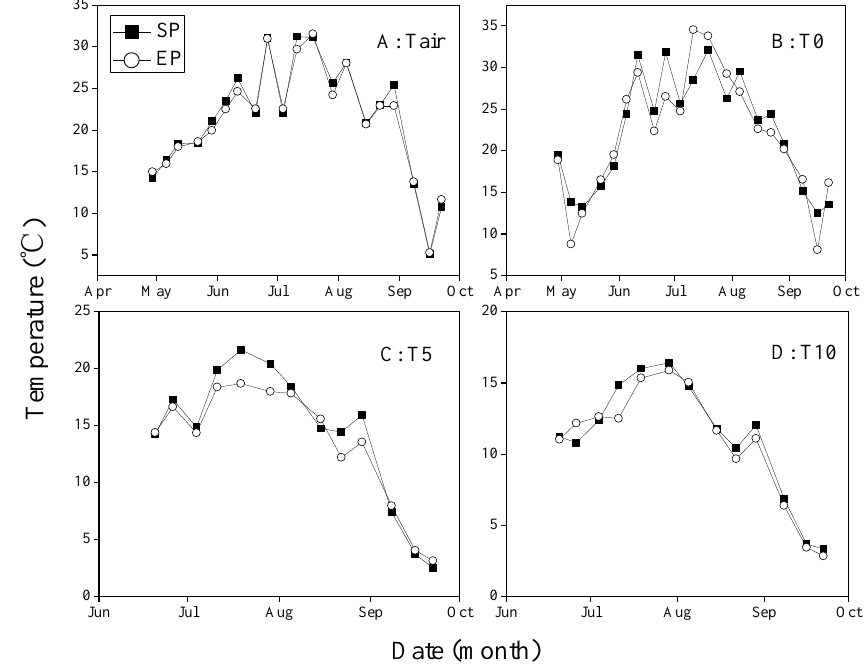
Fig. 2. Temperatures recorded by digital thermometer at SP (shrub–mosses plot) and EP ( Eriophorum plot) sites during sampling in 2011. (A) Air temperature inside the chamber; (B) peat surface temperature; (C) soil temperature at 5cm depth; (D) soil temperature at 10cm depth.